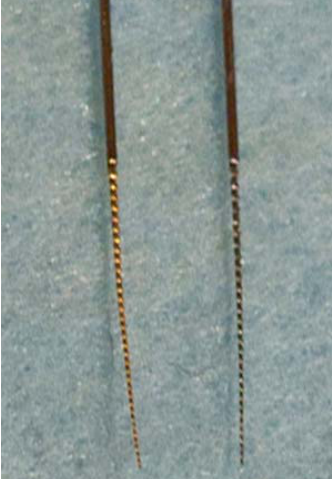
Figure 2. Titanium nitride coated (gold color; left) and uncoated endodontic